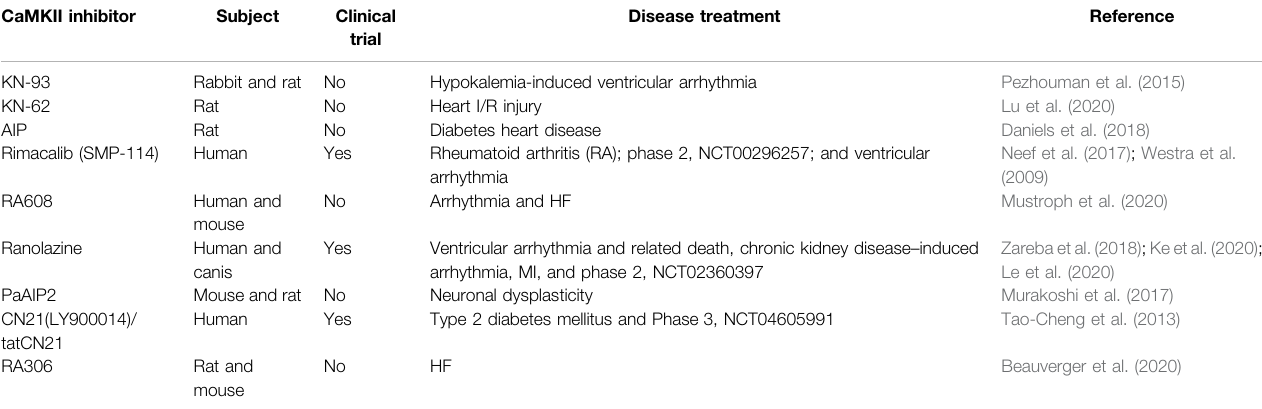
TABLE 2 | Related drugs targeting CaMKII in disease.